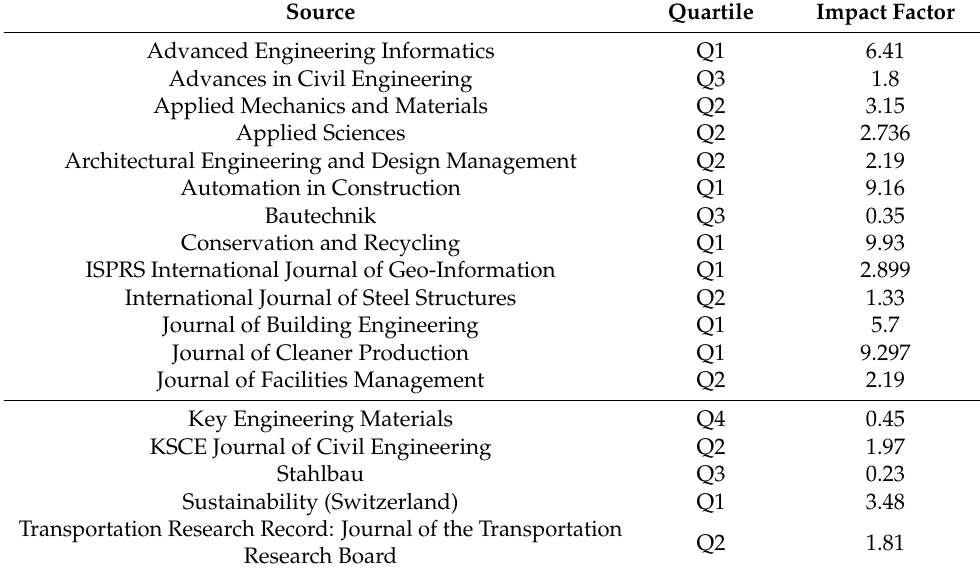
Table 4. Systemic search results.